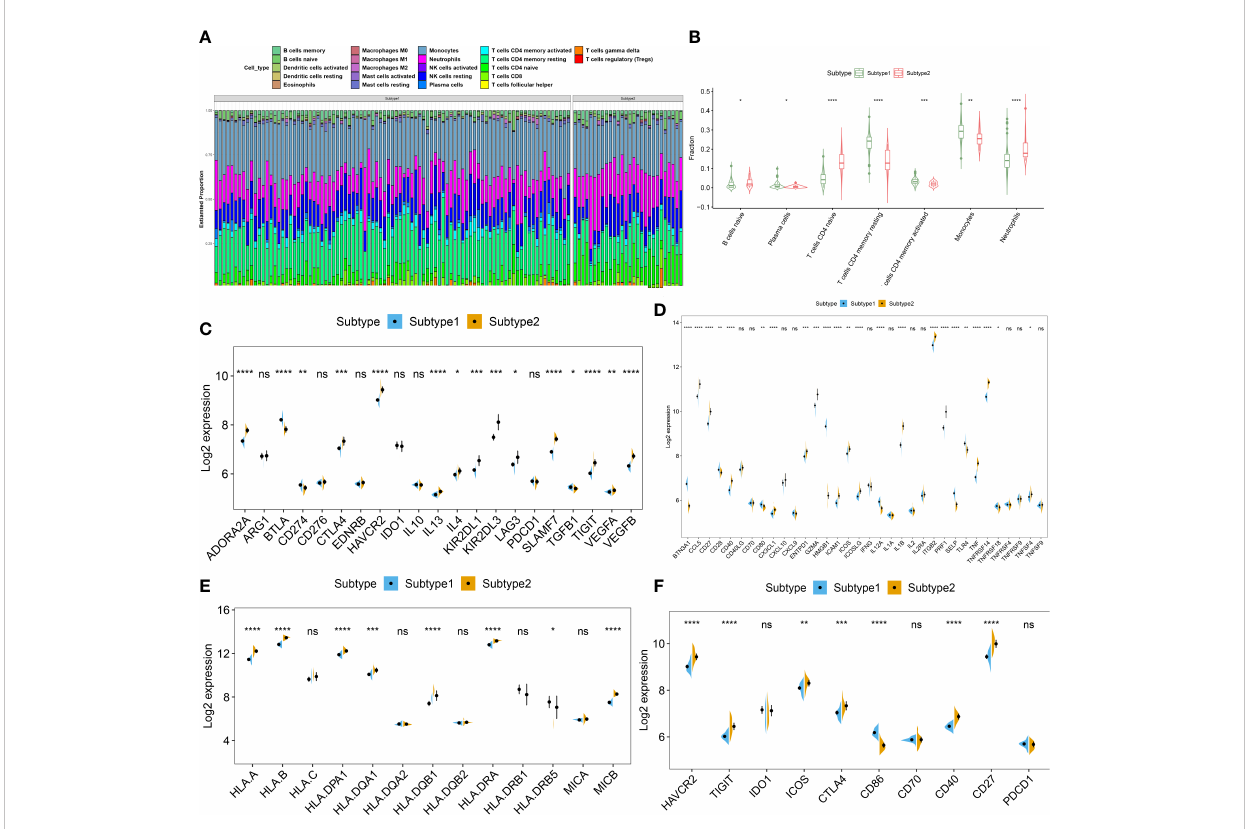
FIGURE 7 Identi fi cation of immunological features between two necroptosis subtypes. (A) Representative stack chart revealing the relative abundances of 22 in fi ltrated immune cells between two necroptosis subtypes. (B) Representative box plots revealing the in fi ltration levels of immune cells between two necroptosis subtypes. (C – F) Representative box plots revealing the expression of immunosuppression (C) , immune activation (D) , MHC- associated genes (E) , and immune checkpoints (F) between two necroptosis subtypes. *p < 0.05, **p < 0.01, ***p < 0.001, ****p < 0.0001, and ns no signi fi